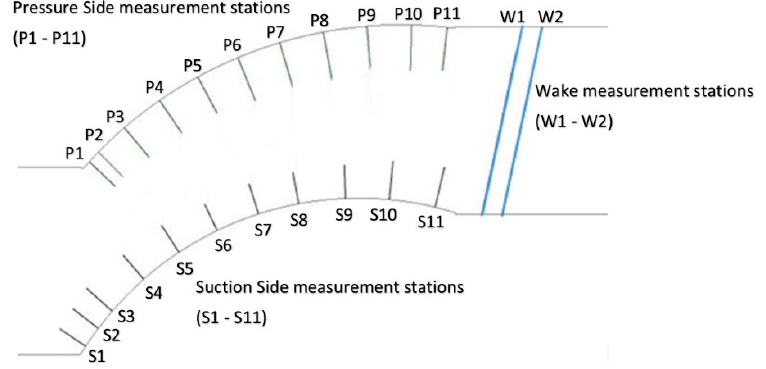
Figure 4. Experimental measurement stations on the DCA pressure, suction sides and wake region.